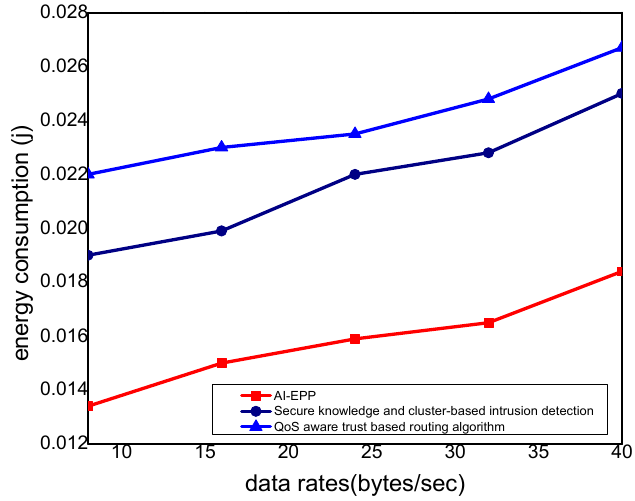
Figure 7. Energy consumption comparison using simulations with varying number of nodes.